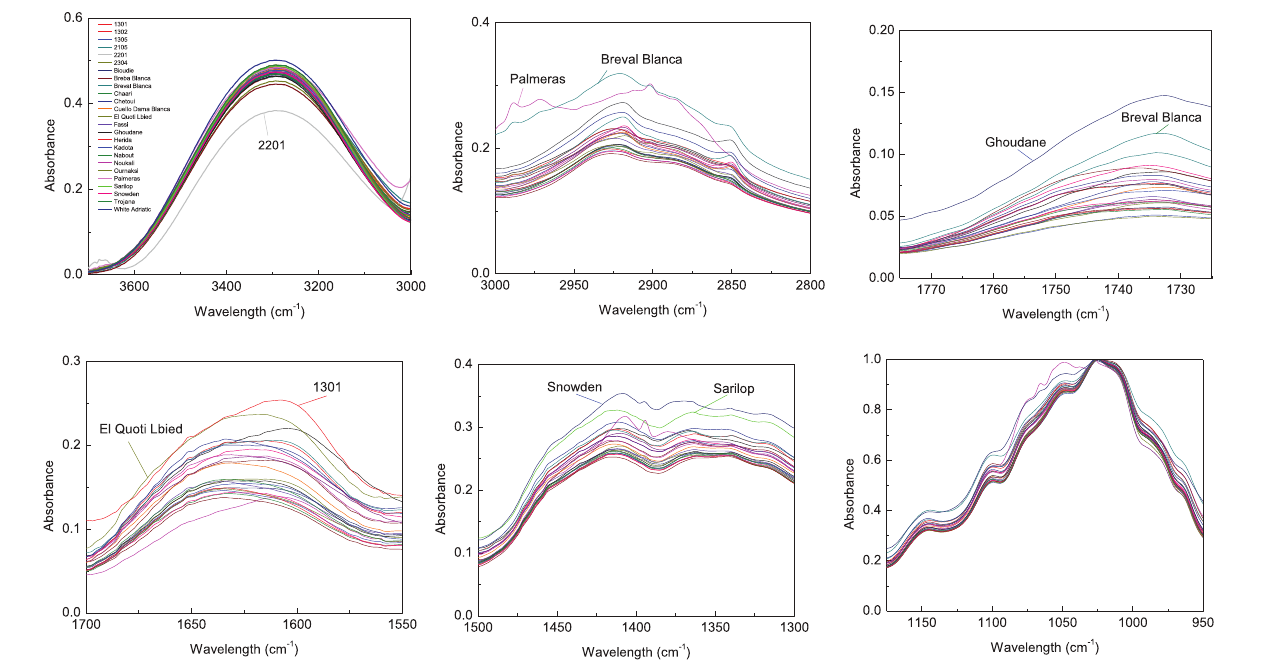
FIGURE 3 | Integrated ATR spectra of the major wavenumbers in peels samples. Each sample IR represent the mean of 3 spectra, which correspond each to the accumulation of 128 scans using a nominal resolution of 4 cm − 1 .